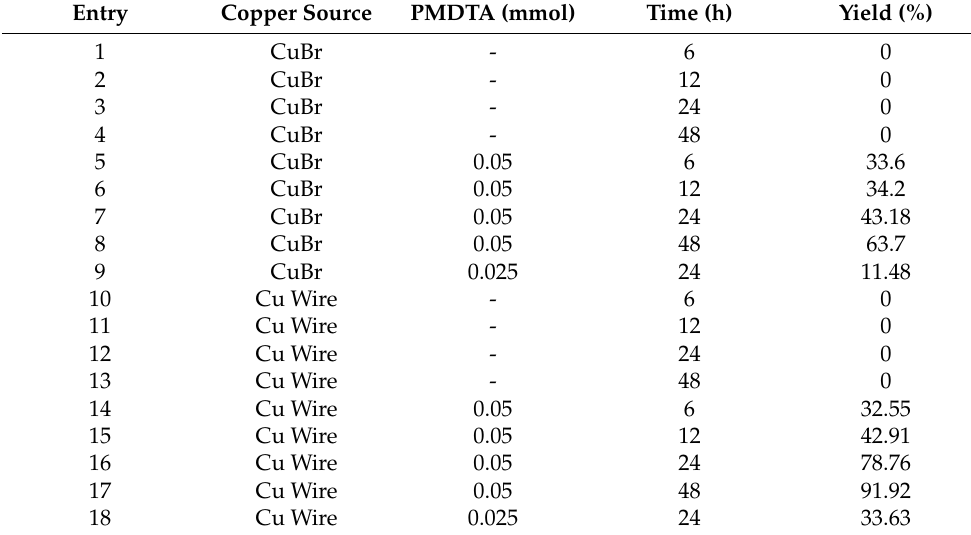
Table 1. Yield of CuAAC reaction with different catalysts using an organic solvent .